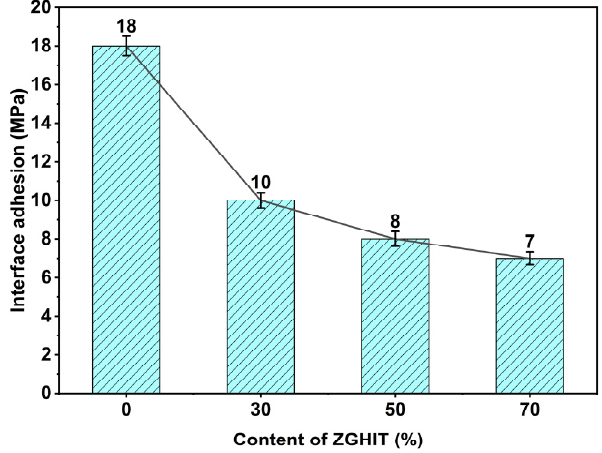
Figure 10. The bonding force between frozen sponge and deicing specimens.